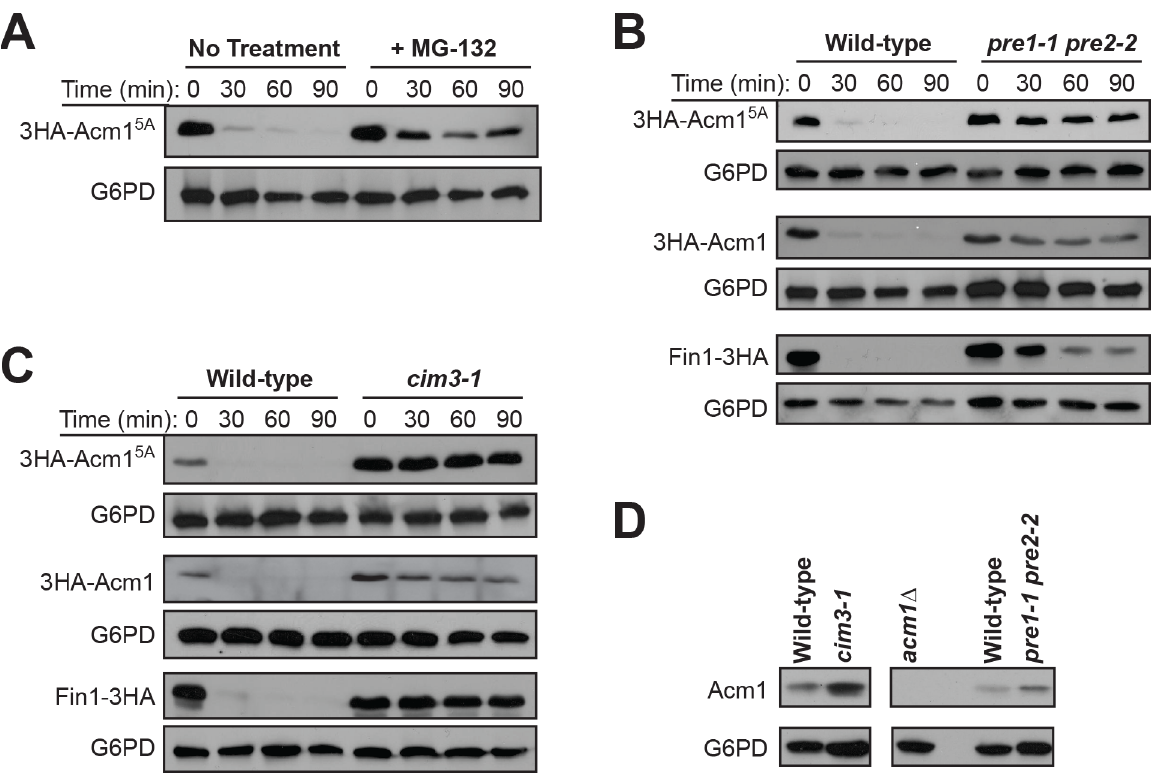
Figure 2. Acm1 degradation requires both the 20S core particle and the 19S regulatory complex of the 26S proteasome. A) Strain YKA407 carrying plasmid pHLP298 expressing 3HA-Acm1 5A from the GAL1 promoter was treated first with galactose to induce 3HA-Acm1 5A expression, second with 50 m M MG-132 or a mock treatment, and third with glucose and cycloheximide to terminate expression (Time=0). The level of 3HA-Acm1 5A was then monitored over time by immunoblotting with an HA antibody. G6PD is a loading control. B) and C) The same experiment described in panel A was performed with wild-type (YWO0607 for B, MHY753 for C) or the indicated temperature-sensitive proteasome mutant strains (YWO0612 for B, MHY754 for C) carrying plasmids expressing either 3HA-Acm1 5A , 3HA-Acm1, or Fin1-3HA from the GAL1 promoter. Instead of MG- 132 treatment, cultures were shifted to 37 u C prior to terminating protein expression. For 3HA-Acm1, and Fin1-3HA, cells were arrested first in G1. D) The same strains from panels B and C were grown to exponential phase and shifted to the restrictive temperature to compare the steady-state level